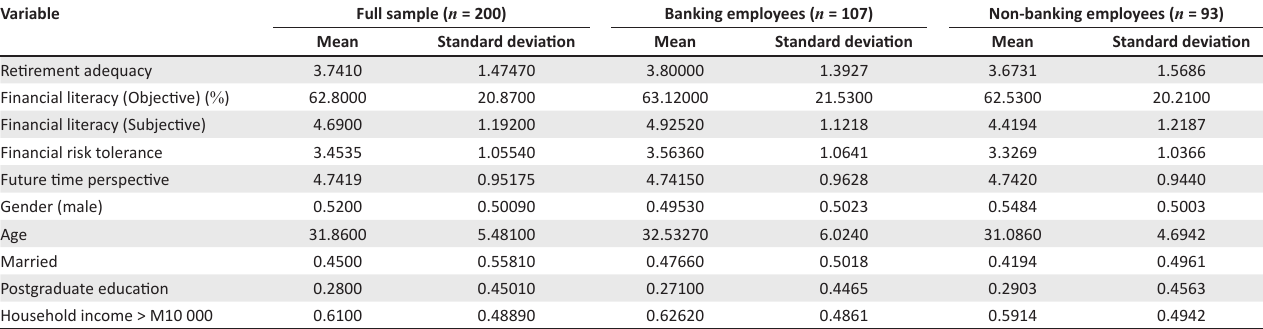
TABLE 2: Reported means of sampled variables. Variable